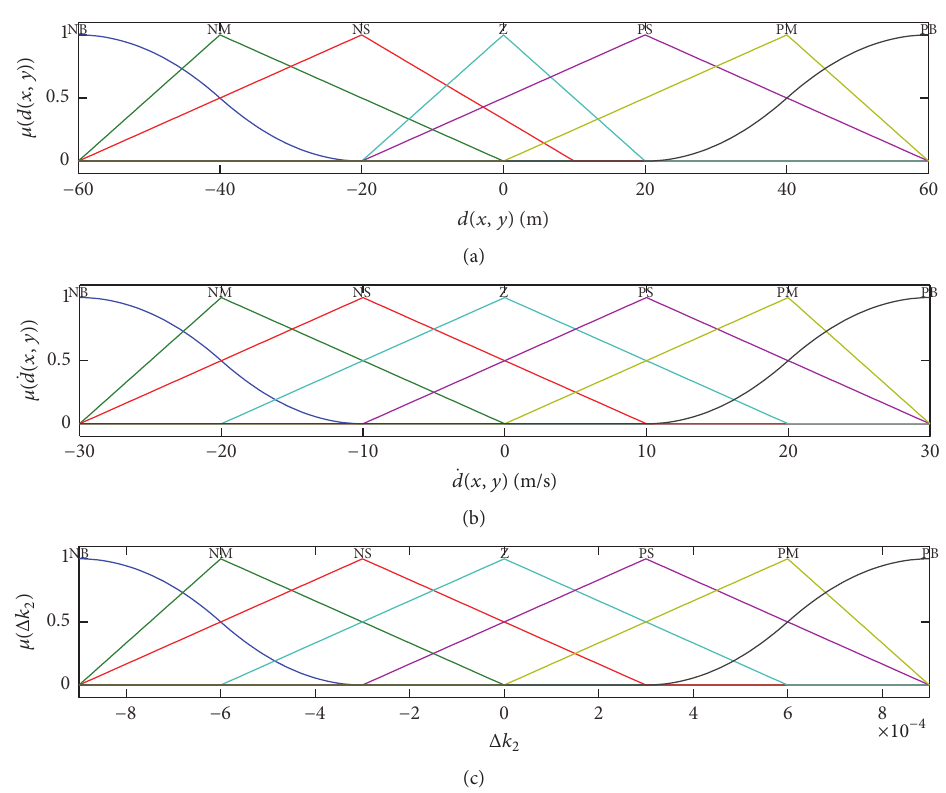
̇𝑑(𝑥,𝑦) and the output Δ𝑘 2 , respectively.